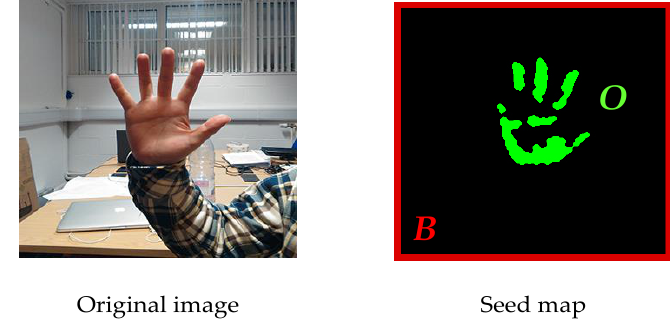
Figure 6. The result of automatic seed selection.